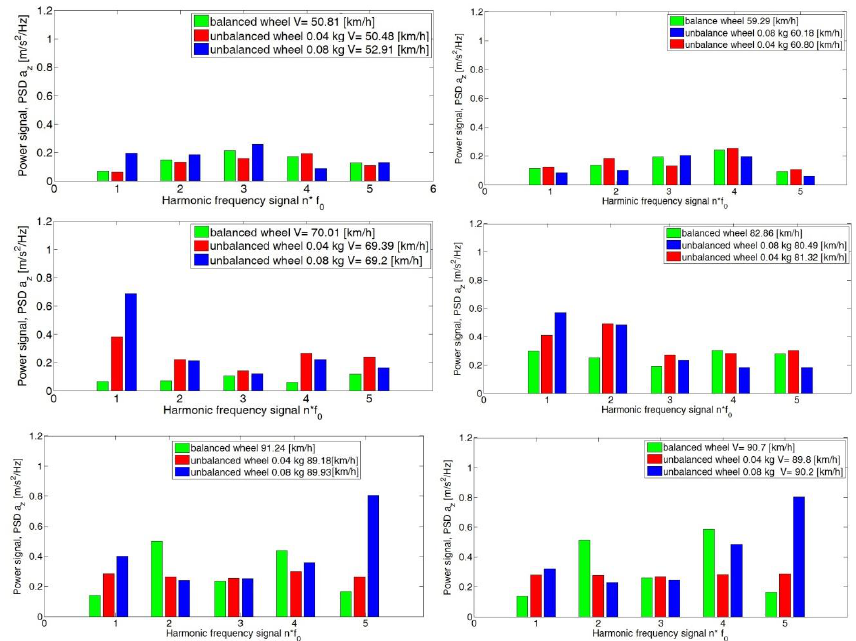
Figure 12. Signal power values of the analyzed z -axis harmonics for the adopted speed ranges for the road test.